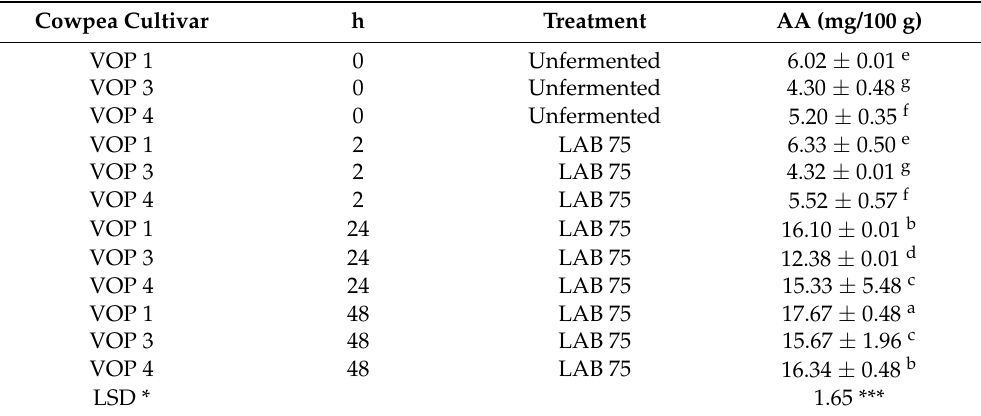
Table 2. Ascorbic acid contents of Ltp. plantarum 75-fermented and unfermented cowpea leaf smoothies from different